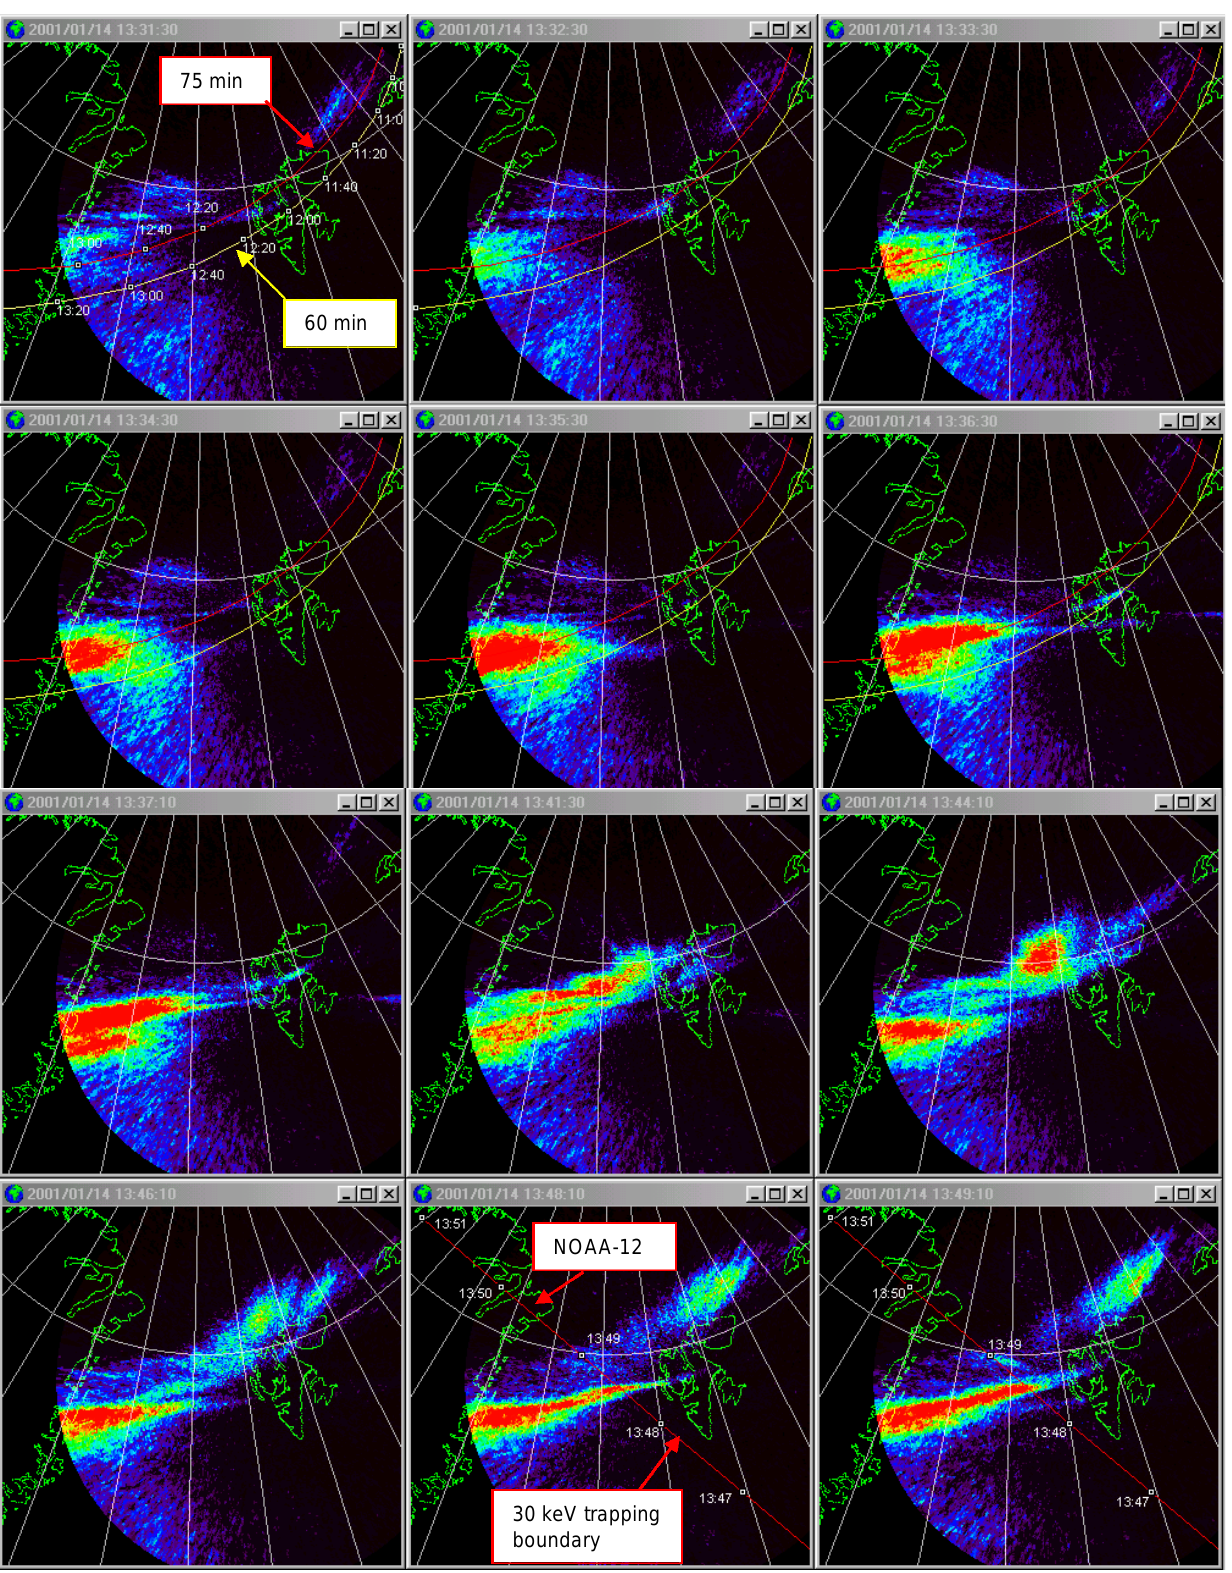
Fig. 7. An all-sky sequence for Cluster event BL-E2 presented in the same format as Fig. 5. The straight red line west of Svalbard in the 13:48:10 and 13:49:10UT frames (bottom row) depicts the flight path of